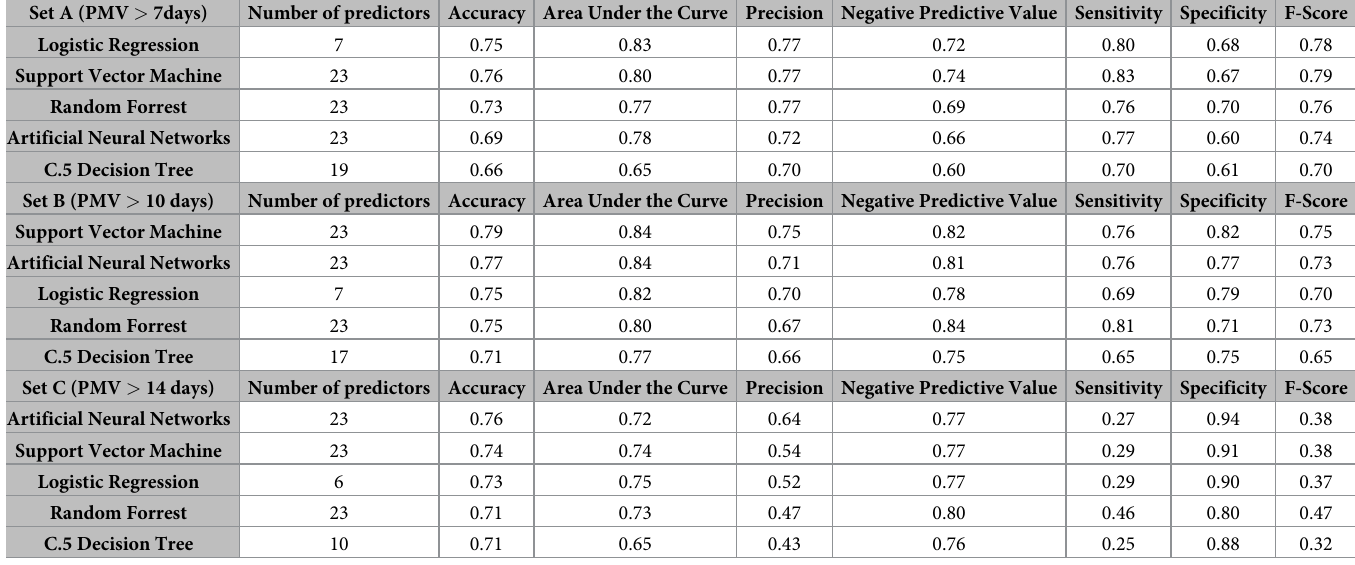
Table 5. Performance of the prediction models. Set A (PMV >